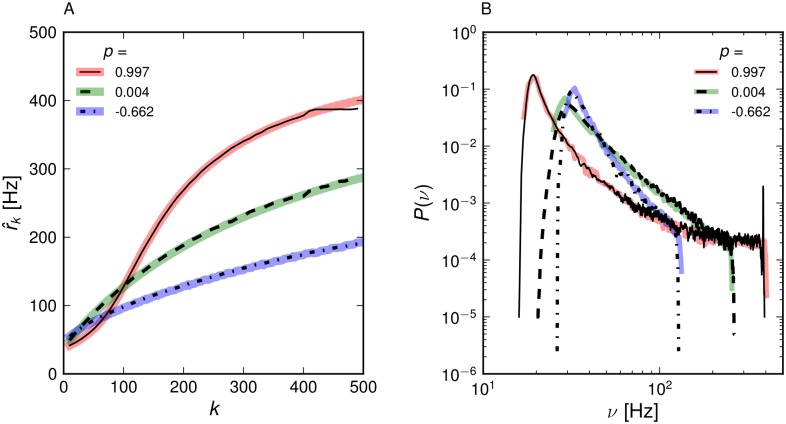
Stationary activity of correlated networks.(A) Population firing rates and (B) distribution of single neuron firing rates for a network with P(k) ∼ k
−2, k = [10, …, 500] for s = 1.2 from simulations (thin full and dotted lines) and theory (thick lines).